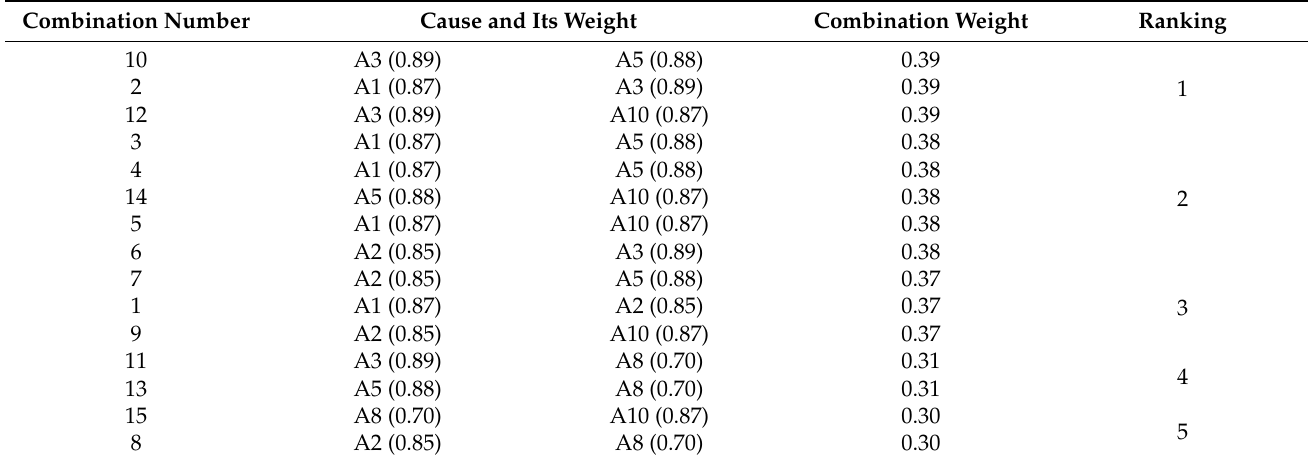
Table 8. Ranking supporting dynamic decision-making about actions to improve a mechanical seal with a cluster of